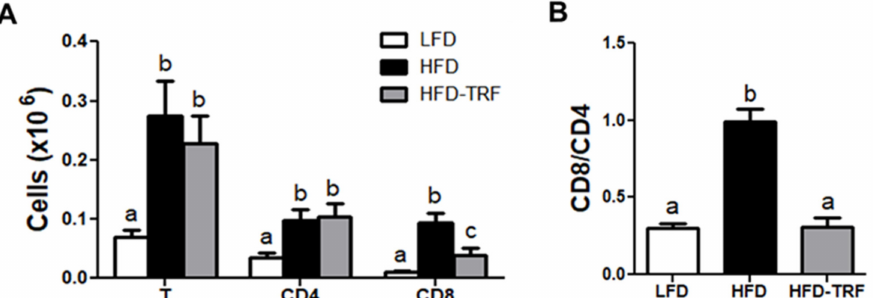
Figure 4. Effects of time-restricted feeding (TRF) on infiltration of T cells. Stromal vascular fraction of epididymal adipose tissue was analyzed by flow cytometry after 14 weeks of different feeding regimens. LFD, low-fat diet ad libitum; HFD, high-fat diet ad libitum; HFD-TRF, 8 weeks of time- restricted feeding after 6 weeks of high-fat diet ad libitum. ( A ) Total T, CD4 T, CD8 T cell numbers; ( B ) ratio of CD8 to CD4 T cells. Data are presented as mean ± SEM ( n = 7). a,b,c Different superscripts indicate significant difference at least at p < 0.05 by ANOVA with Tukey’s post hoc test.